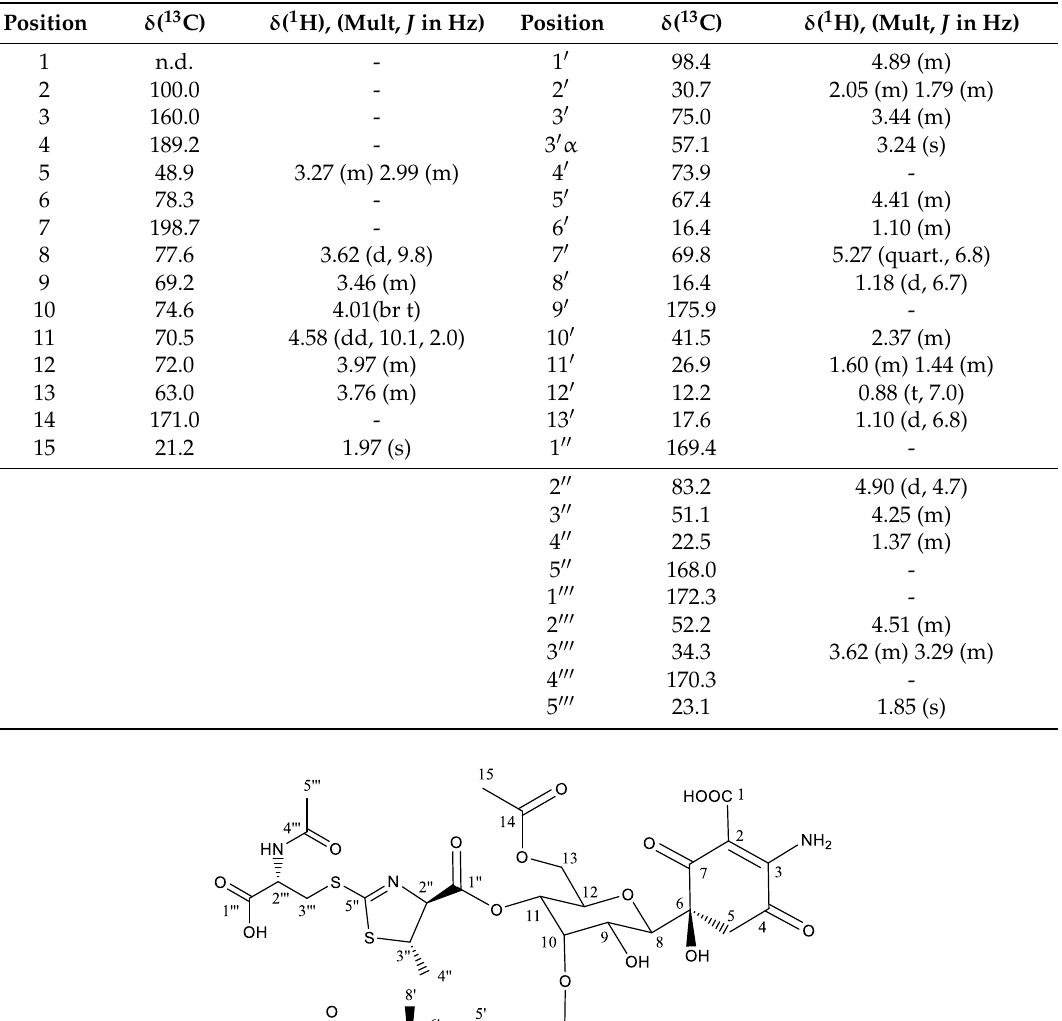
Table 4. NMR data ( 𝛅 in ppm) for compound 4 (DMSO- d 6 , 500 MHz, 24 °C). Carbon chemical shifts derived from HSQC and HMBC spectra.